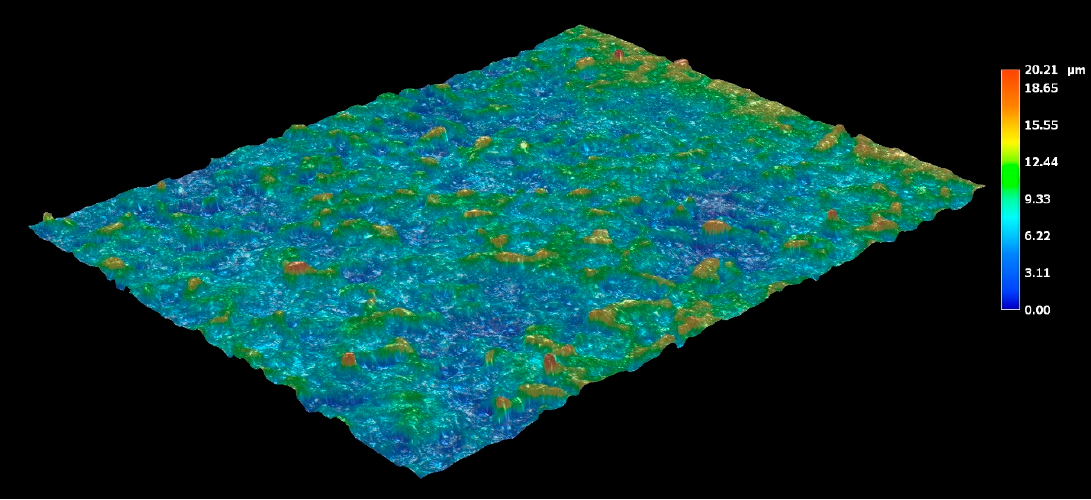
Figure 15. The topography profile of the Al-Si coating on the die-quenched 22MnB5 boron steel.